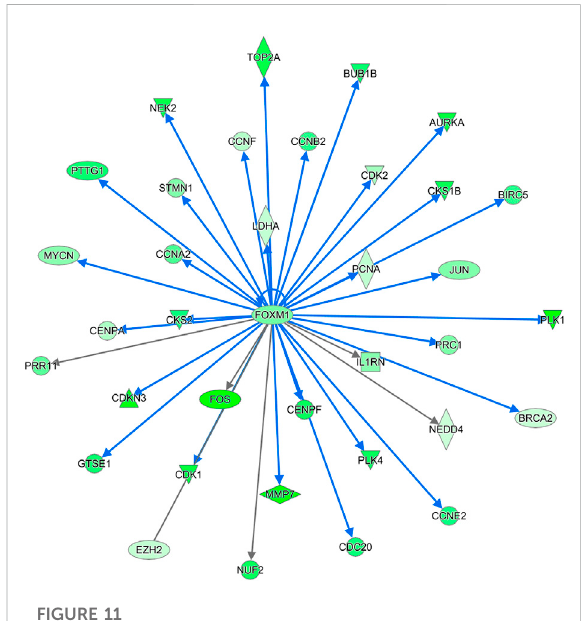
THE FOXM1 regulatory network. FOXM1 was signi fi cantly downregulated in DLY chicks relative to FED chicks. In turn many of the genes it regulates are also downregulated. FOXM1 is a master regulator of many cell proliferation processes. Red molecules were signi fi cantly upregulated and green molecules signi fi cantly downregulated in DLY chicks.